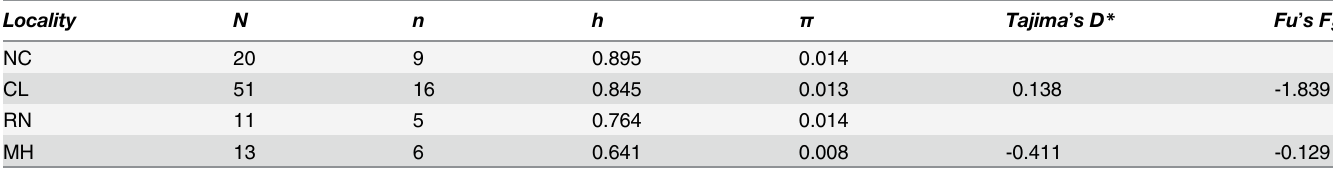
Table 1. Genetic diversity indexes and neutrality tests estimates for each locality and population, respectively. N: sample size; n: number of haplo- types; h: haplotype diversity; π : nucleotide diversity. NC: Necochea; CL: Claromecó; MH: Monte Hermoso; RN: Río Negro. Locality